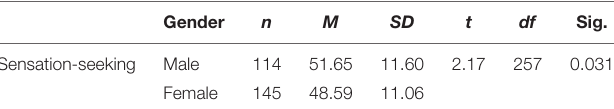
TABLE 3 | Means, standard deviations, and t -test for equality of means of sensation-seeking (SS) according to gender.